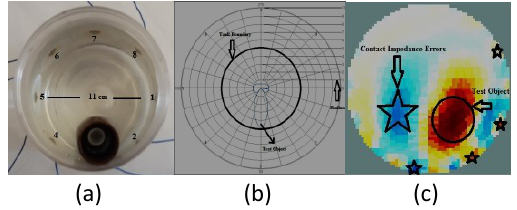
Fig. 4: (a) = actual test object placed along the line of electrode 1, (b) = test object as located using beamforming algorithm. A thick circle represents the actual diameter of the test tank and (c) = test object as indicated by EIDORS. The circle represents the actual object while the stars indicate the contact impedance errors.